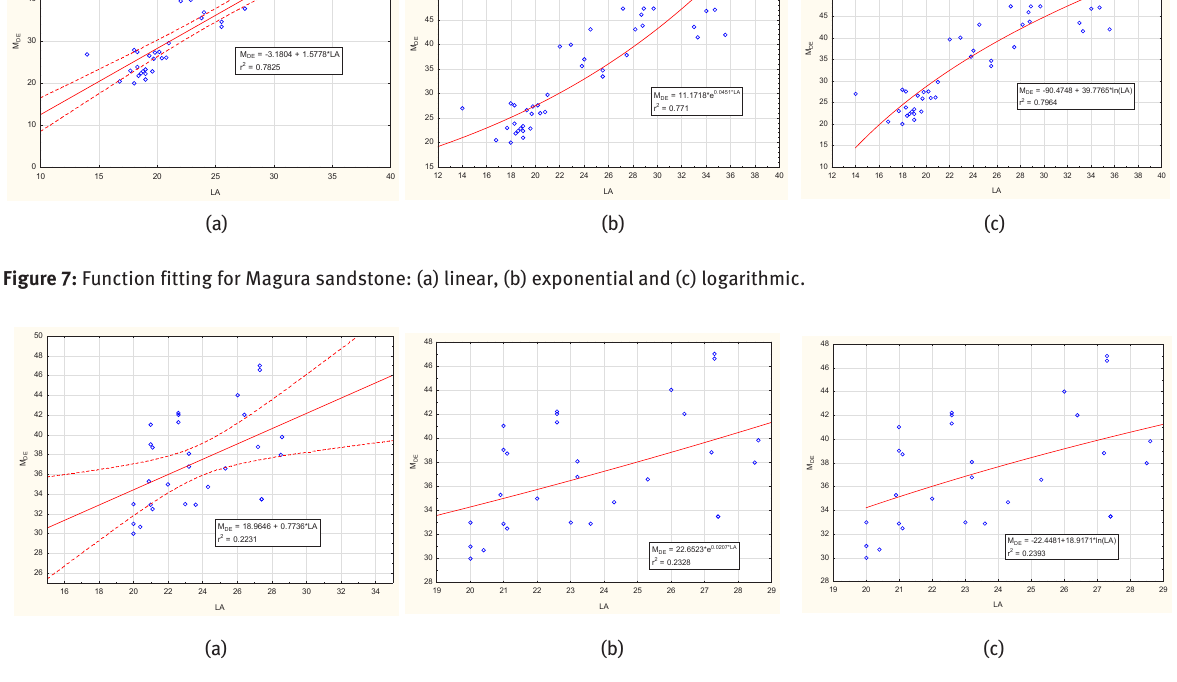
Fig. 7. Function fitting for Magura sandstone: (a) linear, (b) exponential and (c) logarithmic